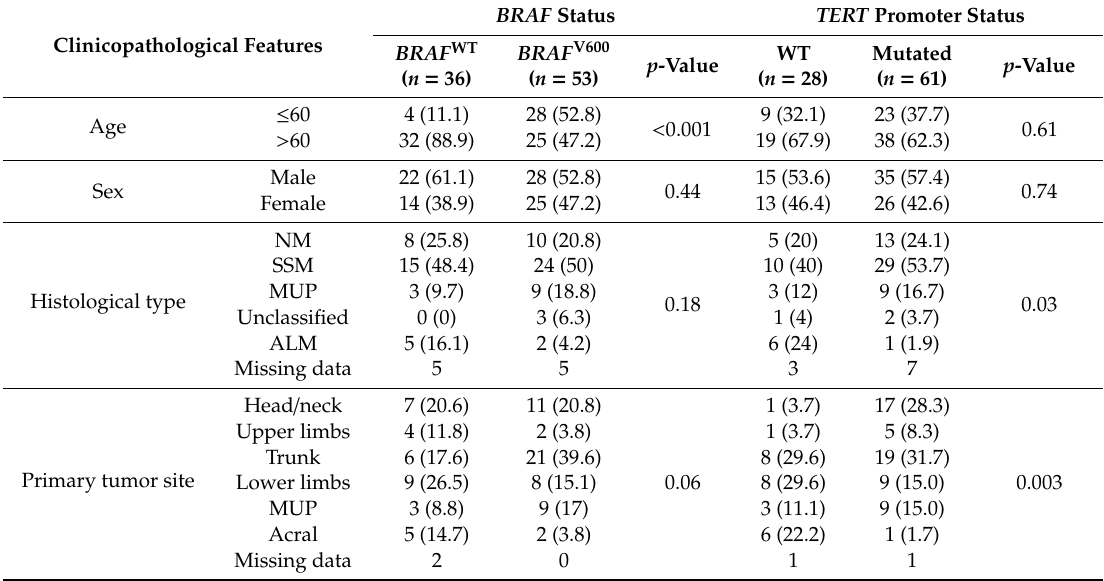
Table 1. Correlation between clinicopathological features and BRAF and TERT promoter mutational